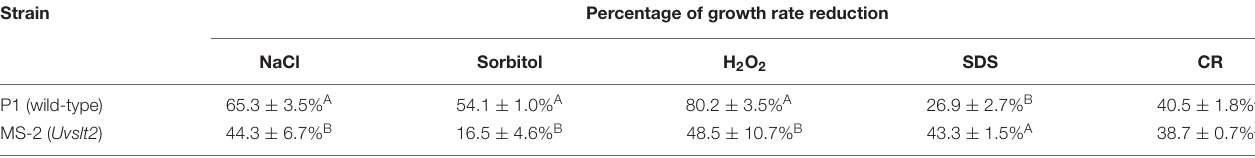
TABLE 3 | Defects of the Uvslt2 mutant in response to different stresses.